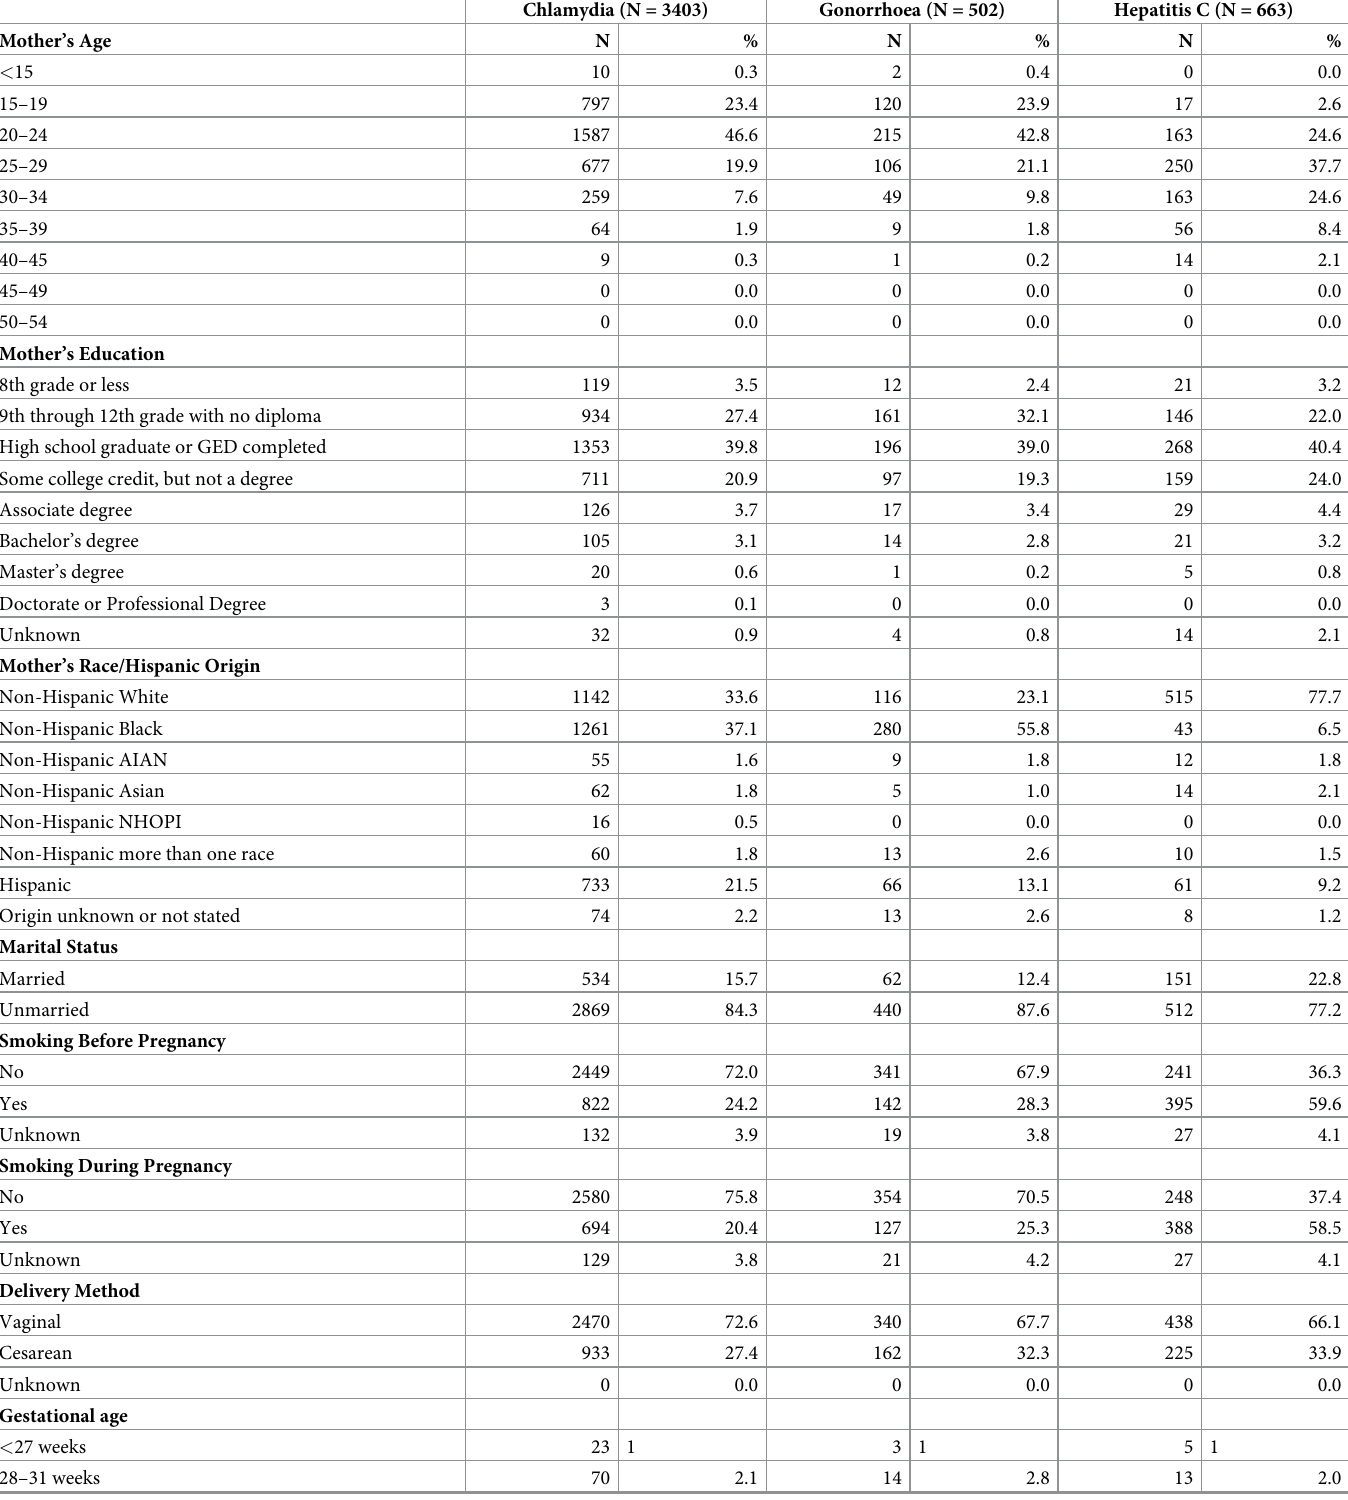
Table 2. Characteristics of the exposures: Chlamydia (N = 3403), Gonorrhea (N = 502) and Hepatitis C (N =